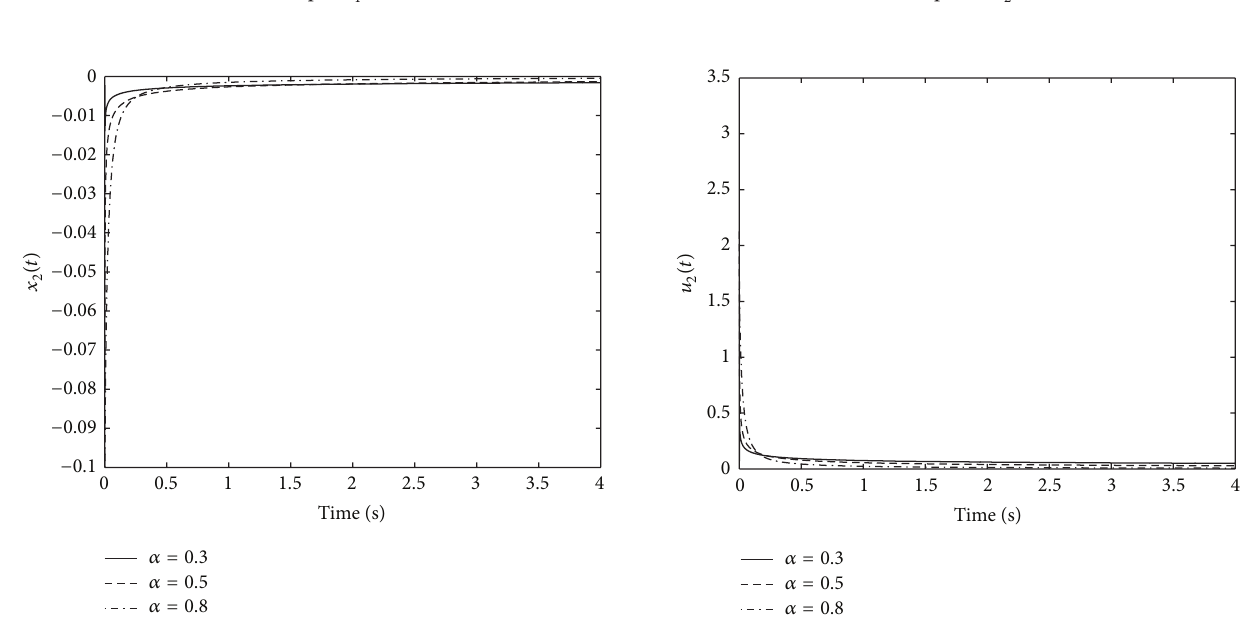
Figure 6: State response 𝑥 2 (𝑡) (1 ≤ 𝛼 < 2) .